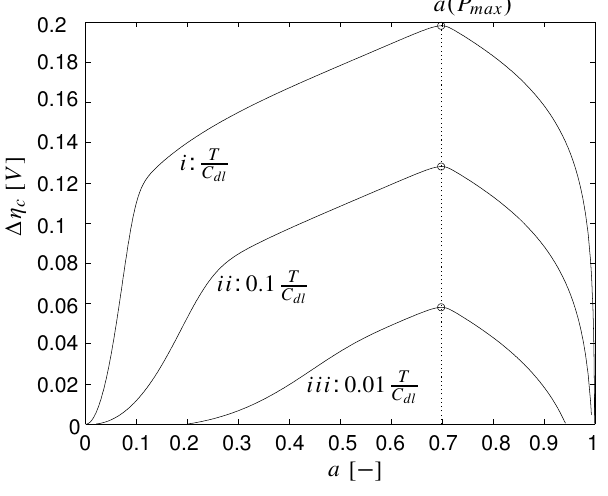
Figure 16. Stationary oscillation amplitudes of the overpotential with respect to the buck- boost converter’s duty ratio a at different ratios of duty period and double layer capacitance T/C ) denotes the duty ratio at the maximal cell power P . The quantity a ( P dl max